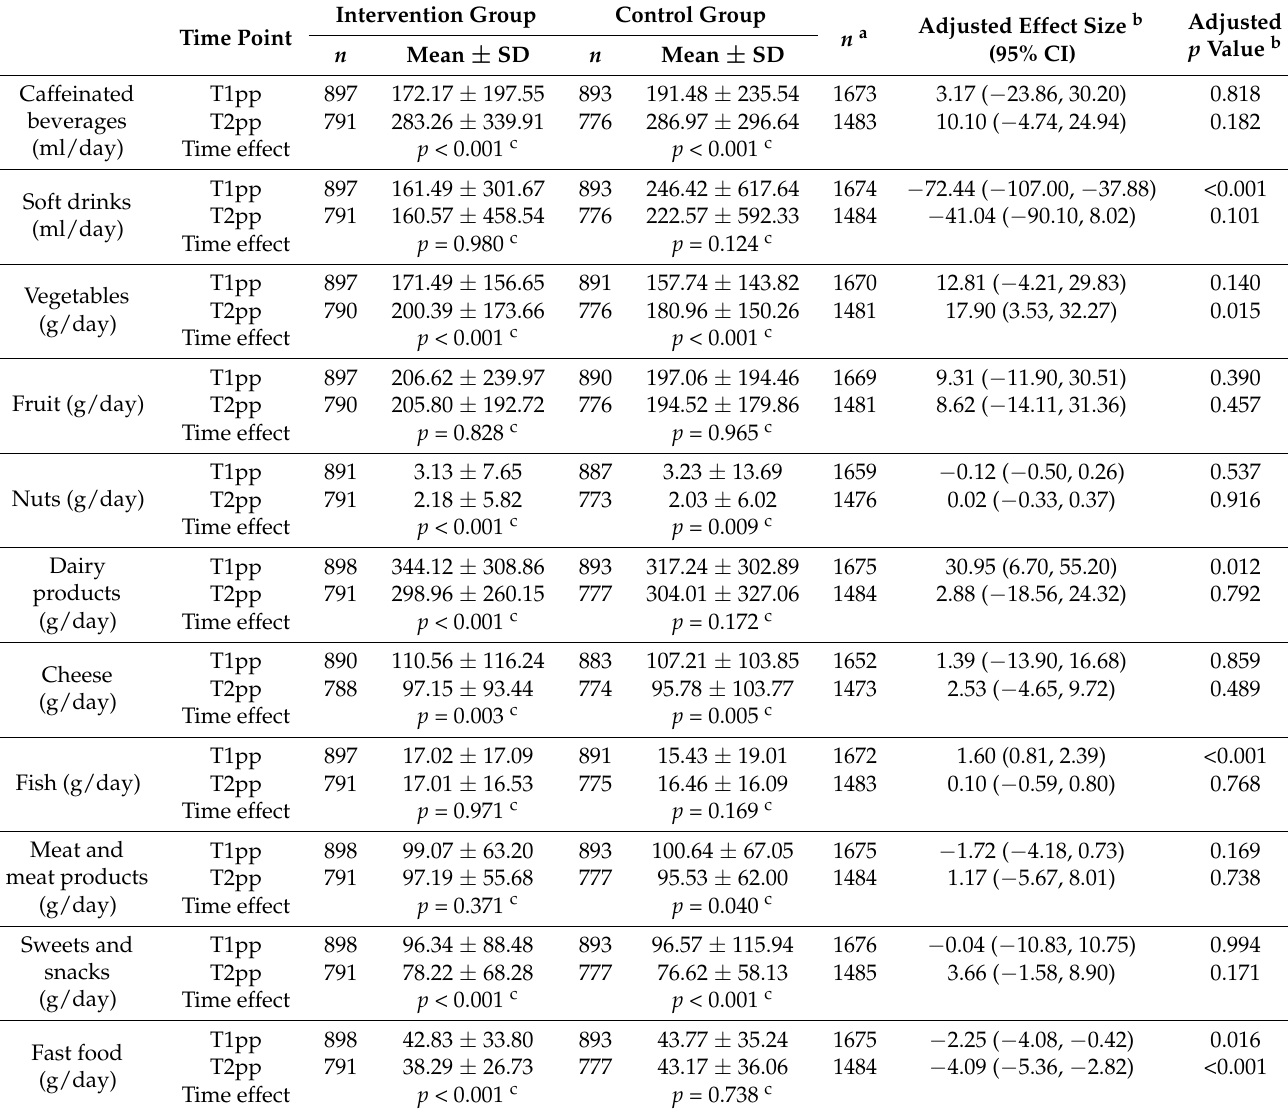
Table 2. Mean daily intake of selected food groups in the intervention and control